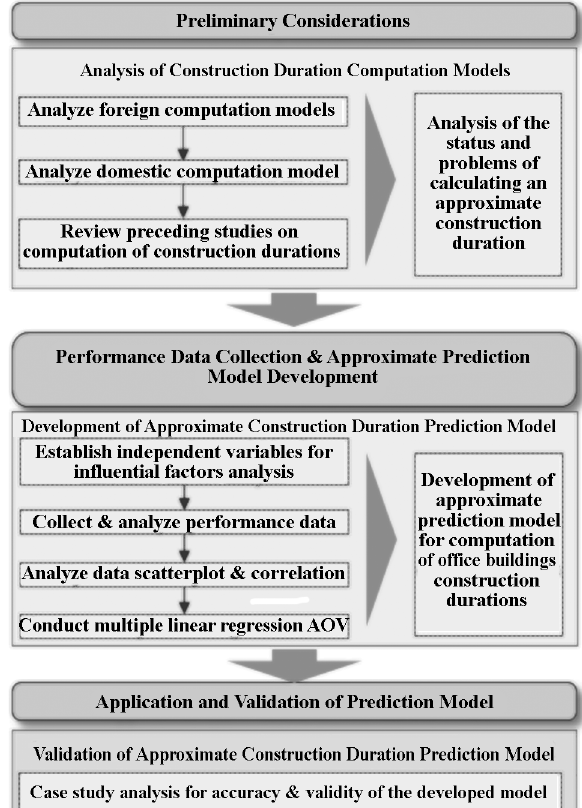
Figure 1. Research method and